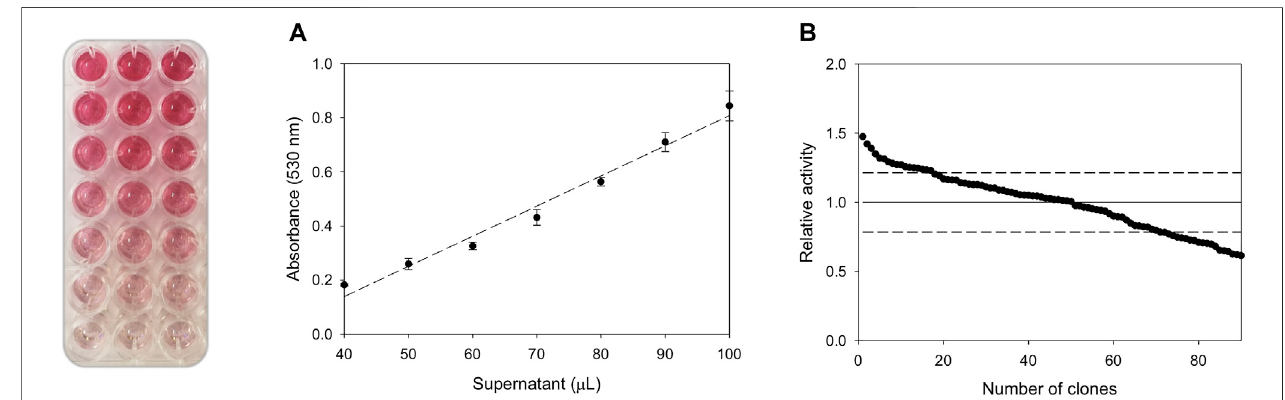
FIGURE 4 | Validation of the colorimetric assay. (A) To assess the linearity of the assay, 40 μ L, 50 μ L, 60 μ L, 70 μ L, 80 μ L, 90 and 100 µL of fresh GroGu supernatants were incubated with 5 mM NNBT (dissolved in acetonitrile 100% v/v) and 2 mM H 2 O 2 in 100 mM KPi buffer [pH 6.0]. The fi nal volume of 150 µL was completed with dd H 2 O. After a 5 min incubation at 30 ° C, 50 µL of the Purpald reagent (50 mM in 2N NaOH) was added to each reaction and shaken vigorously for 10 min.Thereafter,absorbancewasmonitored at530 nmintheplatereader.Eachpointandstandarddeviationcamefromthreeindependentmeasurements. (B) TheCVwasdeterminedin S.cerevisiae cellstransformedwithpJRoC30-GroGuandplatedonSCdropoutplates.Individualcolonieswerepickedandinoculatedina96 well plate, and the activity of the clones was evaluated in fresh supernatant preparations. The activities were plotted in descending order, the dashed lines indicating the CV of the